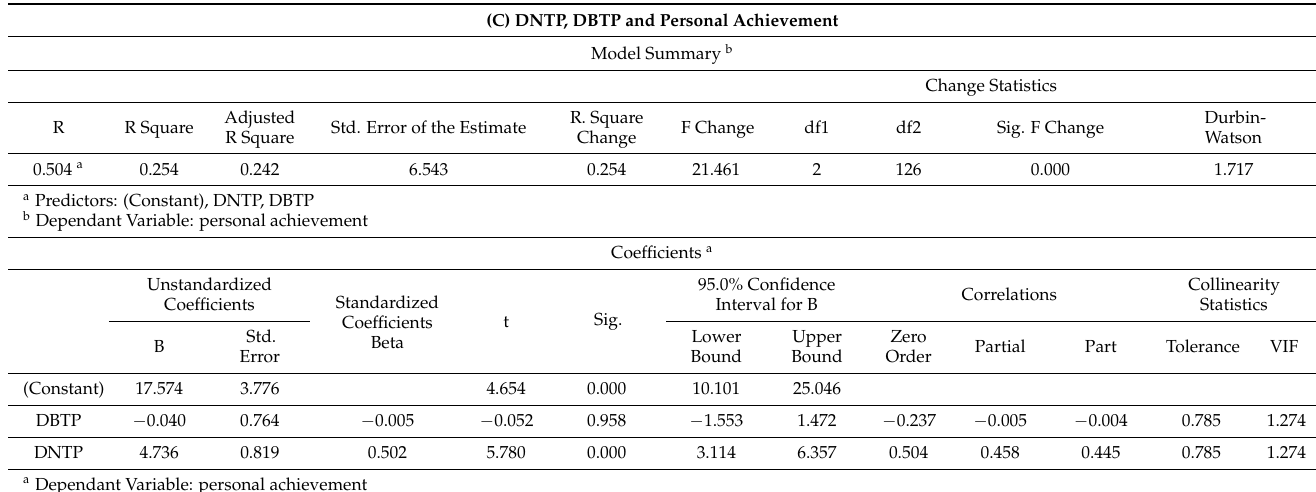
Table 8. Linear Regression of Personal Achievement.